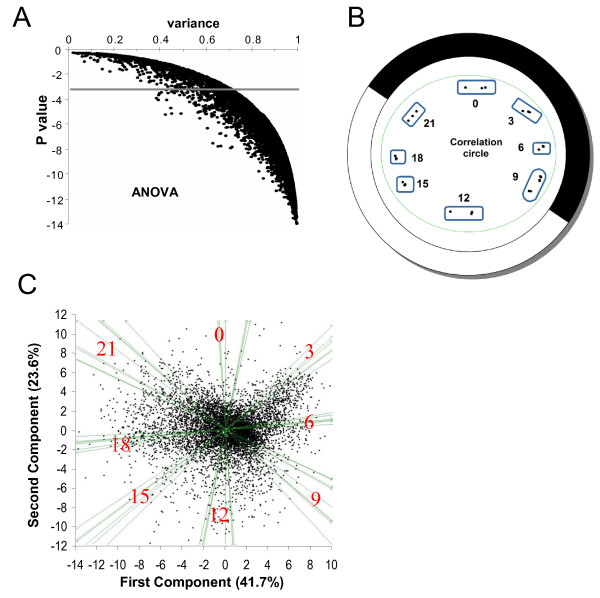
Differential gene expression in O. tauri subjected to LD 12:12 cycles. (A) ANOVA Analysis. 6822 probes detect genes with differential expression over 3 LD cycles with a Pvalue < 10-3. (B) Principal Component Analysis (PCA) of samples collected at different times of the LD cycle represented on a correlation circle. White and Dark represent light and dark period respectively (12:12; Light ON at Time 9; Light OFF at Time 21). Biological replicates are shown separately as dots. Note that the Time 9 overlapping time points are grouped. (C) Separation of genes by the first and second components of PCA shown on the x and y axis, which represent 41.7% and 23.6% respectively. The main axis partition morning/evening and night/day time points. At time 0, fewer genes are expressed.